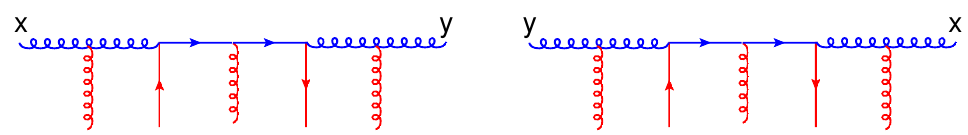
Figure 3 . Typical diagram and cross-diagram for gluon propagator in the background of quark (cid:12)elds. As usual, we indicate in blue the quantum (cid:12)eld while in red the background